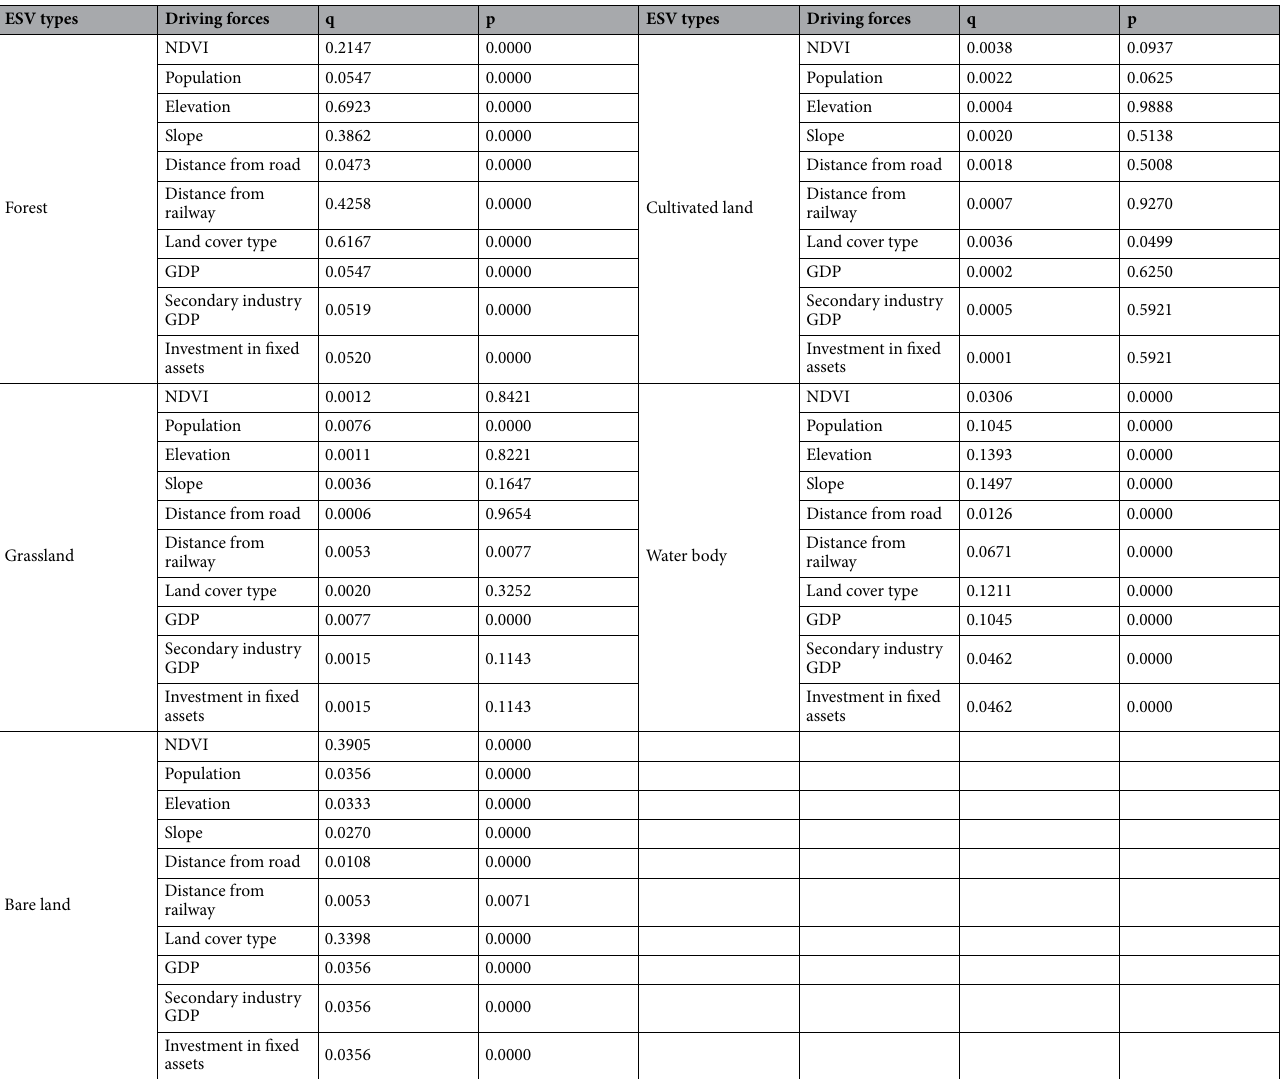
Table 7. Geographic detection results of ESV for each land use